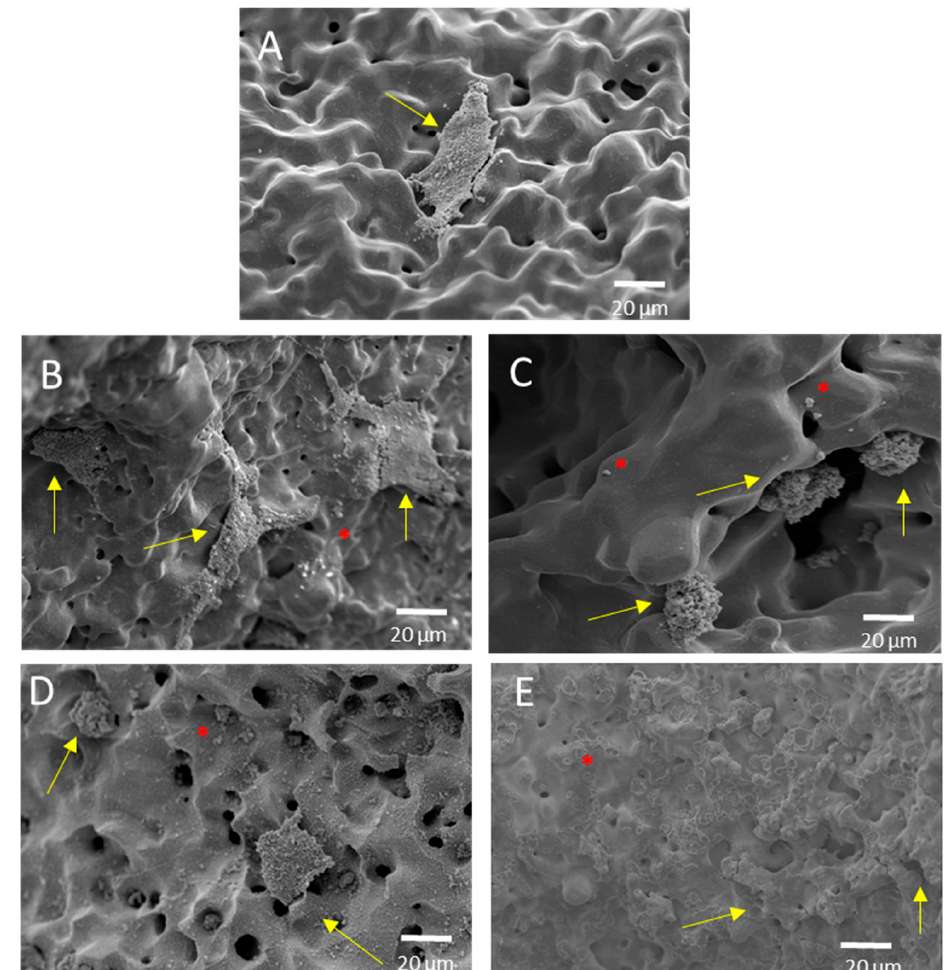
Figure 9. Representative SEM images of the cell adherence in different surfaces of porous dental implants. Virgins: ( A ) PM conventional, ( B ) SH 30 vol.%, ( C ) SH 50 vol.%, and superficially modified. ( D ) Chemical etching and ( E ) BG 45S5, both on conventional PM implants. Note: The cells are indicated in the images (yellow arrow), along with calcium phosphate (red asterisk).